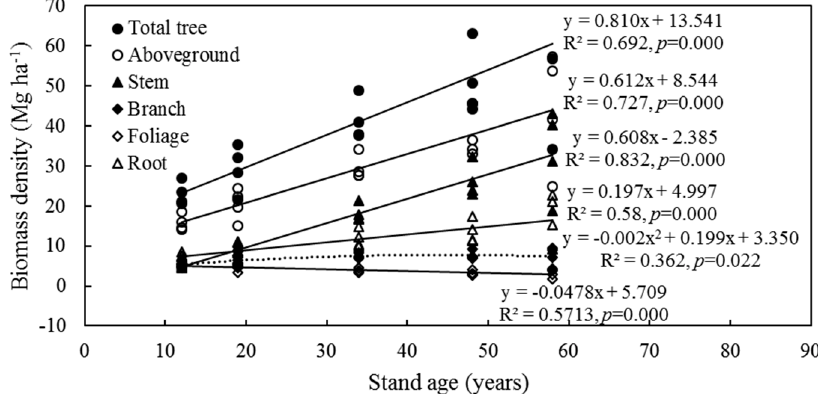
Figure 4. Biomass density of tree components versus stand age of Mongolian pine ( Pinus sylvestris L. var. mongolica Litv.). The solid line and dotted line represent linear regression and polynomial regression, respectively.